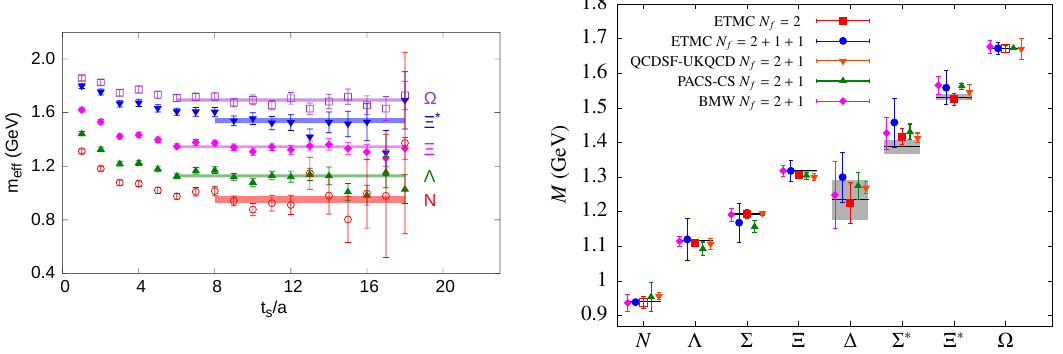
Figure 3: Left: The effective mass of low-lying baryons. Right: the mass of the low-lying octet and decuplet baryons from various collaborations extrapolated to the continuum limit. The horizontal bands are the experimental values. Open symbols indicate the input used to fix the lattice spacing (nucleon) and strange quark mass ( Ω −